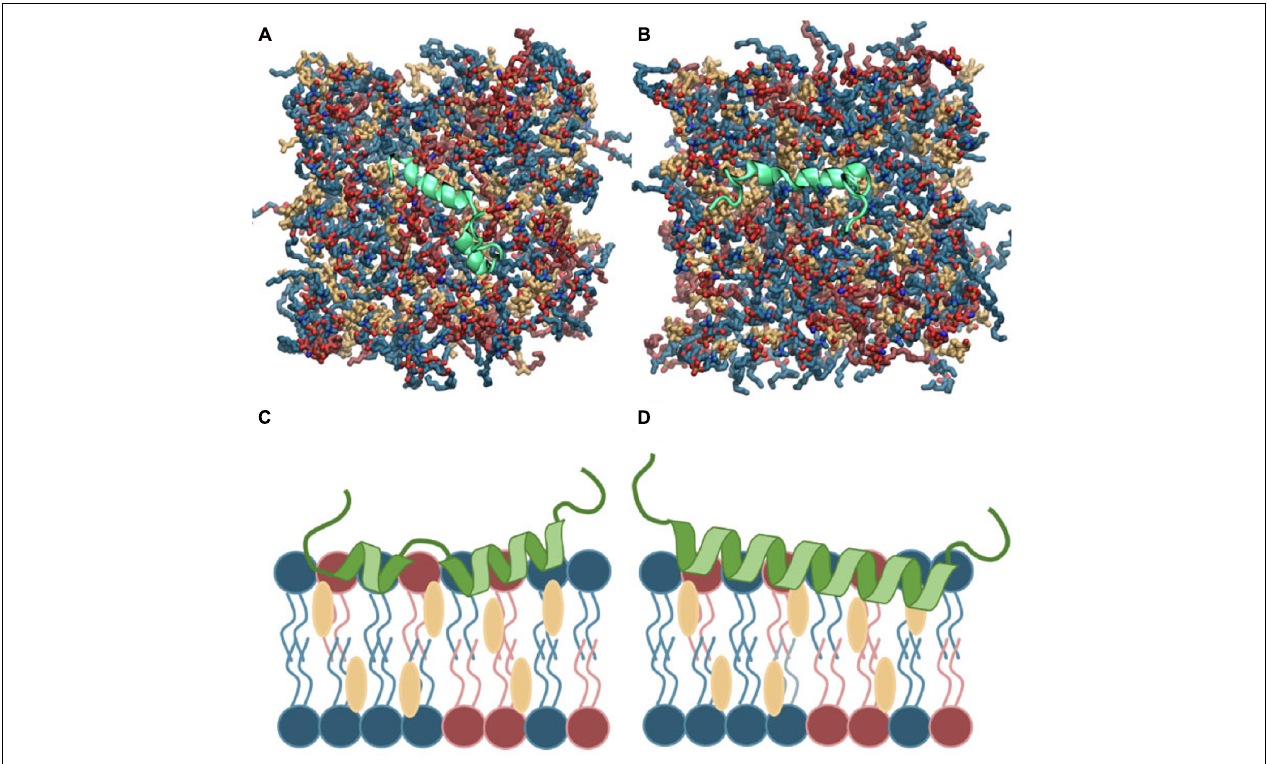
FIGURE 2 | (A,B) Top view of the atomistic starting structures of kinked and straight IAPP peptides in the membrane bound helical conformation. Water and ions are not shown. (C,D) Sketches of the membrane bound state of kinked and straight IAPP peptides shown from the side. The peptide is illustrated in green and DOPC, DOPS, and CHOL are shown in blue, red, and yellow,